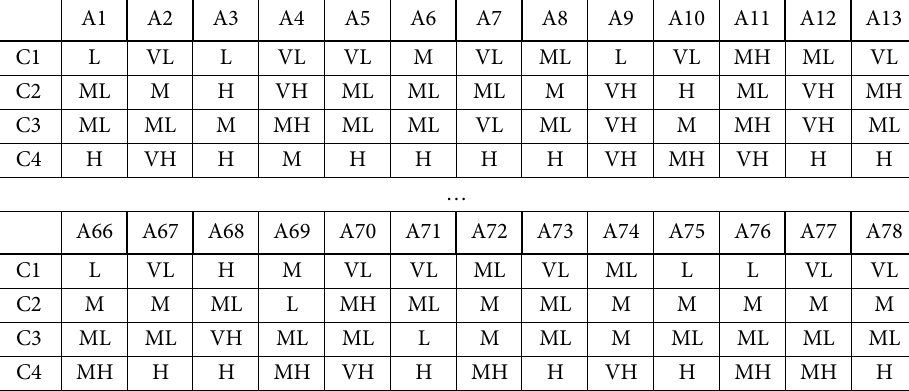
Table 2. Initial decision-making matrix with linguistic